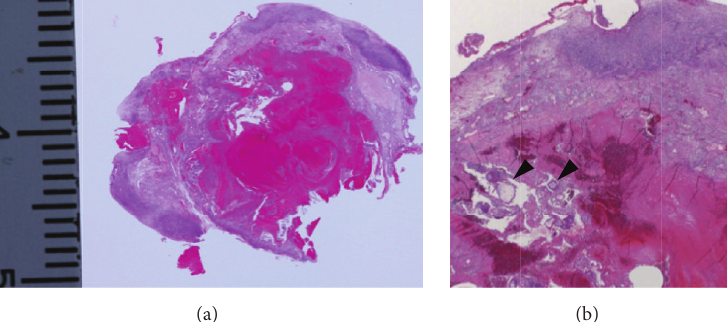
Figure 3: (a) Postoperative pathology, corresponding to the MR image, illustrates chorionic villous structures surrounded by ovarian stroma. (b) Photomicrograph shows chorionic villous structures (arrowhead) (H&E stain, 40x